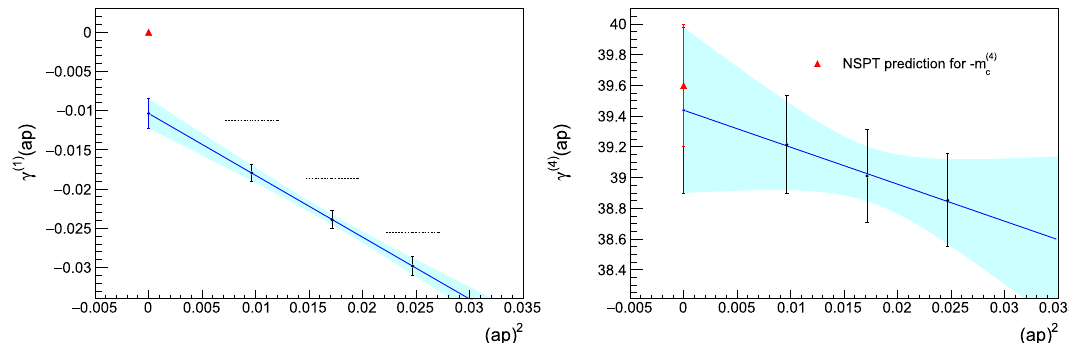
Fig. 3 Determination of the coefficient m ( 4 ) c . Although γ ( 1 ) ( ap ) does not extrapolate to zero, the extrapolation of γ ( 4 ) ( ap ) is compatible with the value known from Ref. [40]. Notation as in Fig. 1